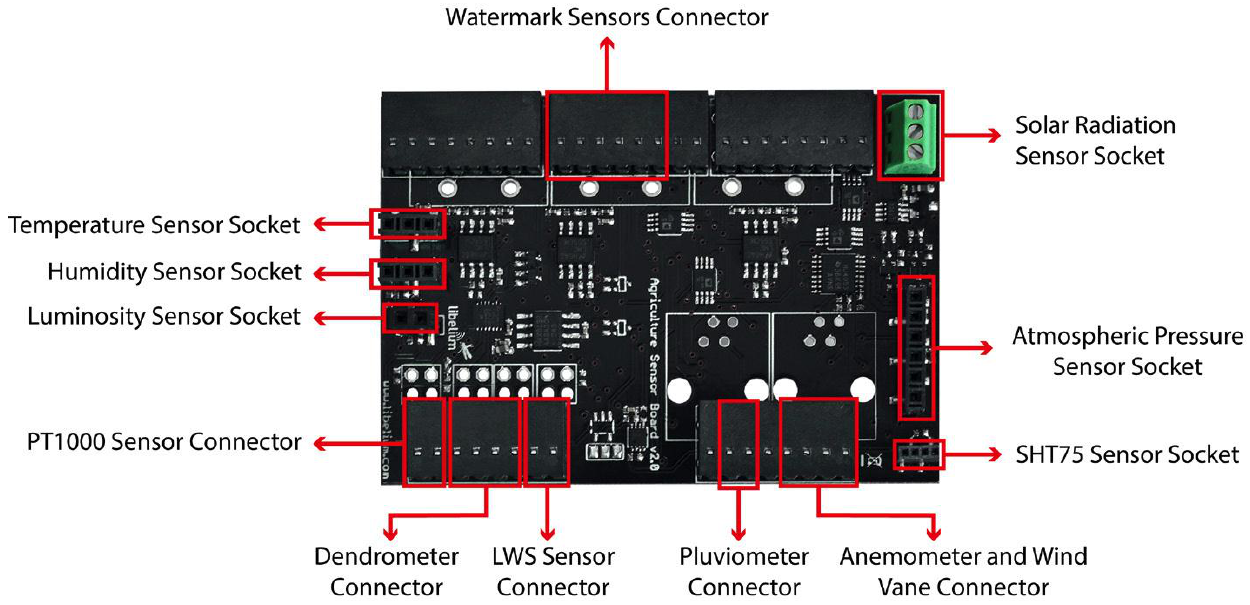
Figure 2. Anatomy of agriculture sensor board PRO. LWS (leaf wetness